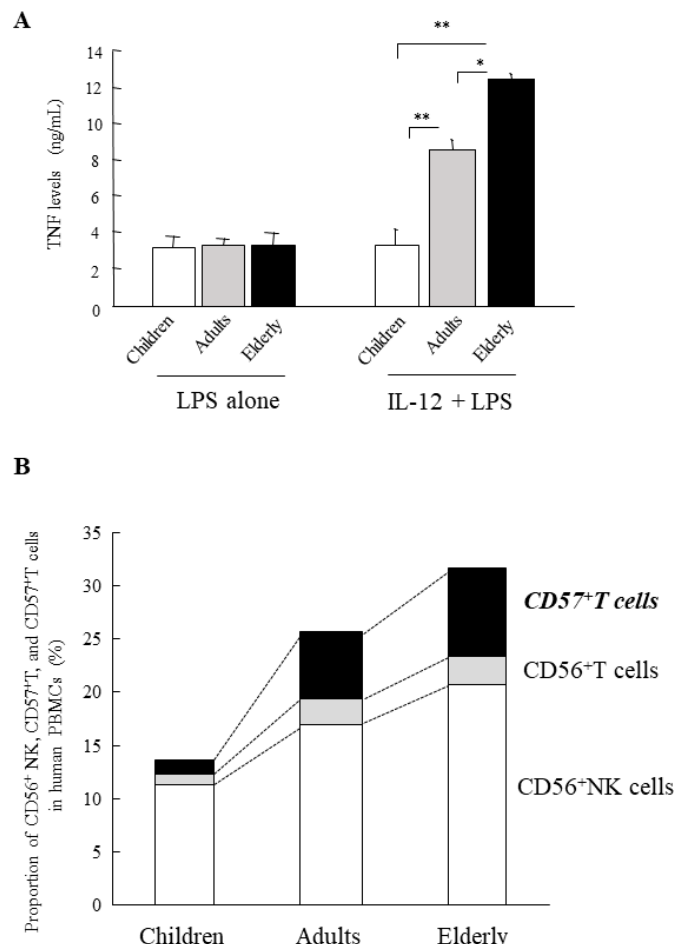
Figure 5. Age-dependent increases in TNF production from human PBMCs by stimulation with IL-12 and LPS and age-dependent increases in CD56 + NK, CD56 + T and CD57 + T cells in human PBMCs. ( A ) Human PBMCs age-dependently increased TNF production by stimulation with LPS following IL-12 stimulation but not by LPS stimulation alone. ( B ) The proportions of CD56 + NK, CD56 + T, and CD57 + T cells were age-dependently increased in human PBMCs. In particular, CD57 + T cells were markedly increased age-dependently. Data are mean ± SE ( A ) and mean ( B ) from seven, ten, and six healthy volunteers in the child, adult, and elderly groups, respectively. ** p < 0.01, * p < 0.05, using an analysis of variance with Sche ff e’s F test. Figures are revised from